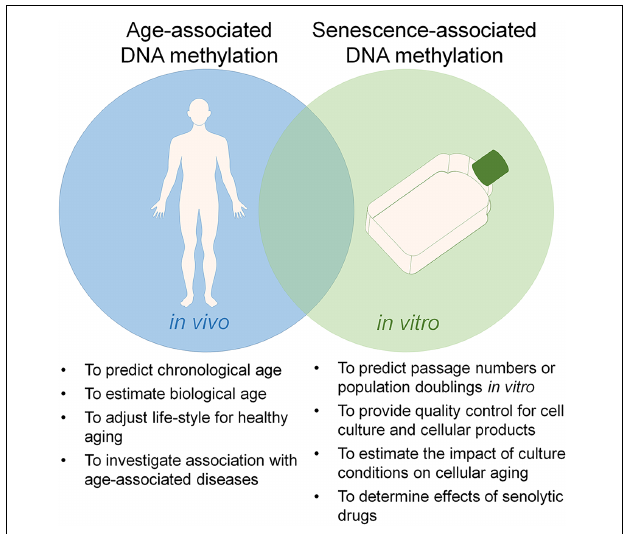
FIGURE 1 | Utility of epigenetic clocks for aging and senescence. Aging and replicative senescence are both reflected by highly reproducible DNA methylation (DNAm) changes and there is a significant overlap between these epigenetic modifications. On the other hand, the two processes can be tracked independently by epigenetic signatures, which can be utilized for different